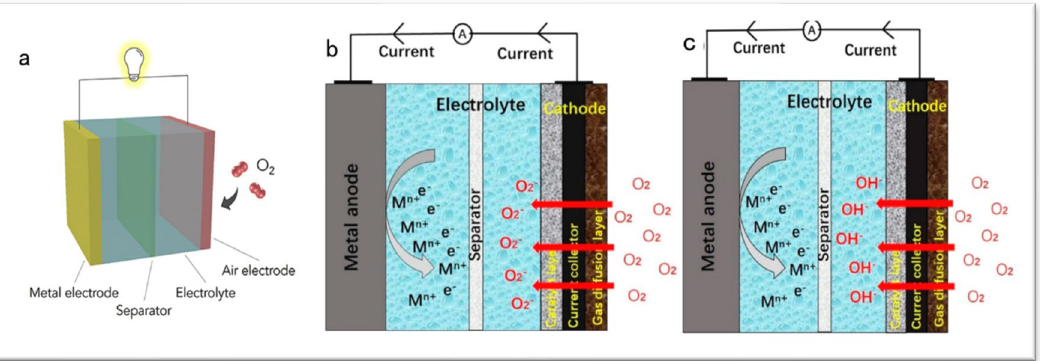
Figure 1. Schematic illustration of the composition and working principle of metal–air battery. (a)